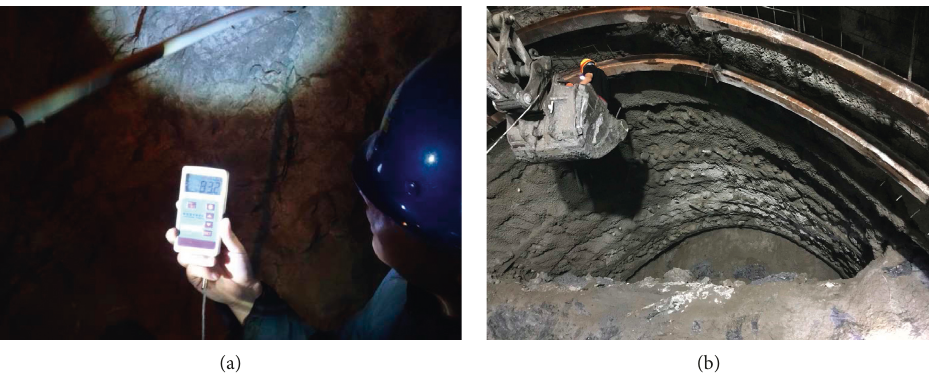
Figure 1: Construction environment inside the tunnel: (a) hot-dry environment inside the tunnel and (b) hot-humid environment inside the